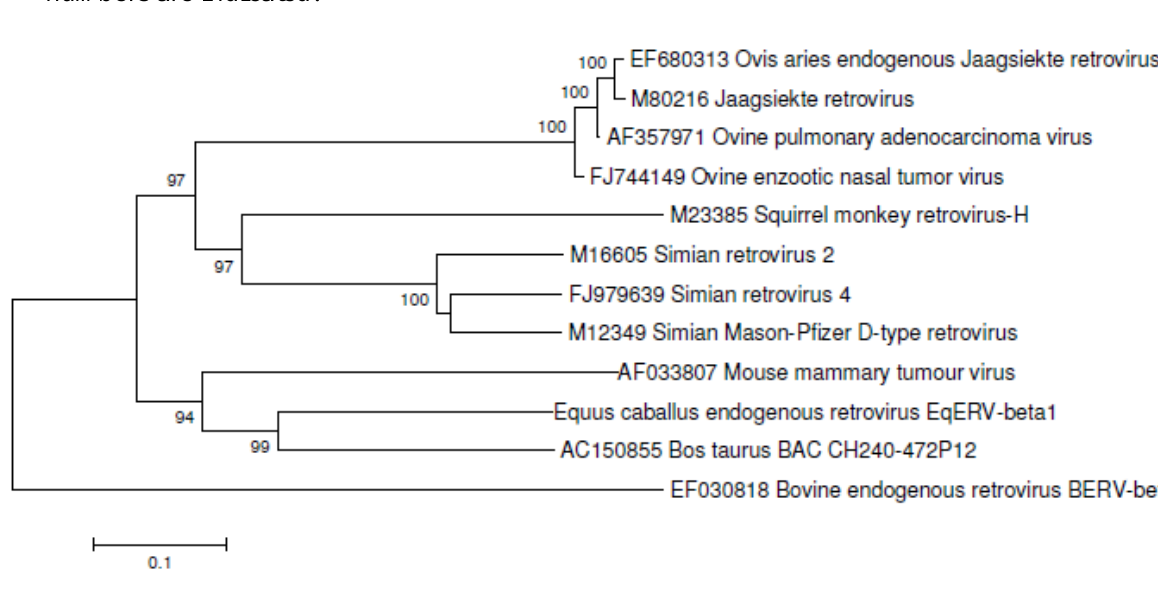
Figure 4. Phylogenetic analysis of the translated pol gene of EqERV-beta1 and reference translated pol sequences from beta- and delta-retroviruses was performed using the Neighbor-Joining option in MEGA4.0 with a Poisson distribution of amino acid substitutions and equal rates among sites. Five hundred bootstrap replicates were analyzed. Bootstrap values >90 are shown. Sequences had been aligned using the Clustal W option as implemented in BioEdit [17], and alignments were adjusted manually. GenBank accession numbers are